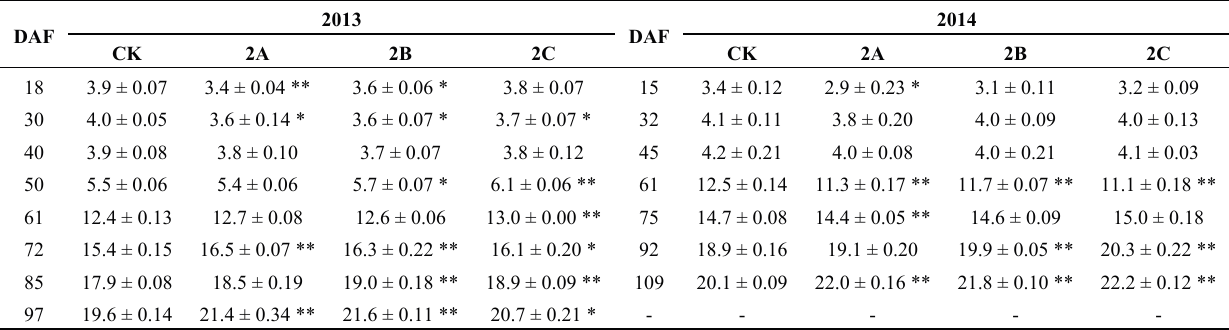
Veraison stage corresponds to 61 DAF in both years. The asterisk represents the total soluble solids of berries in the zinc treatment group is significantly different than the control group at 1% level (for two asterisks) and 5% level (for one asterisk),